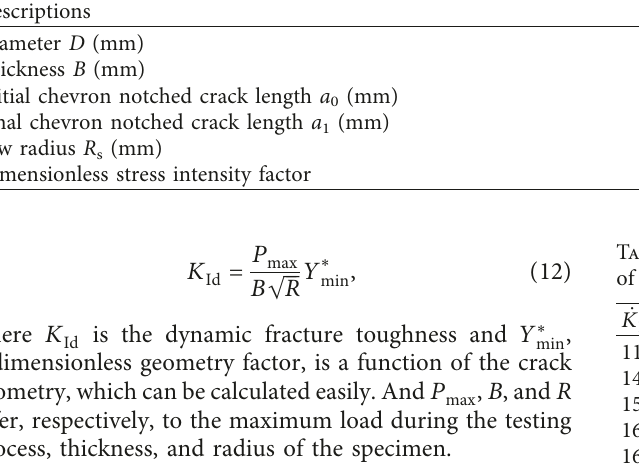
Figure 5: Geometry of the CCNBD specimen recommended (a) and the flattened CCNBD specimen (b). Table 3: Geometry of the standard CCNBD.